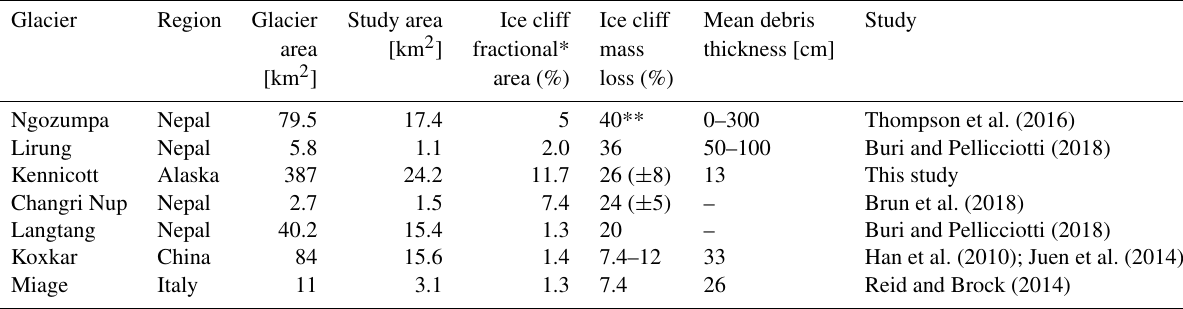
Table 4. Comparison of ice cliff coverage and melt contribution with other debris-covered glaciers. Glacier Region Glacier Study area Ice cliff Ice cliff Mean debris Study area [km 2 ] fractional* mass thickness [cm] [km 2 ] area (%) loss (%) Ngozumpa Nepal 79.5 17.4